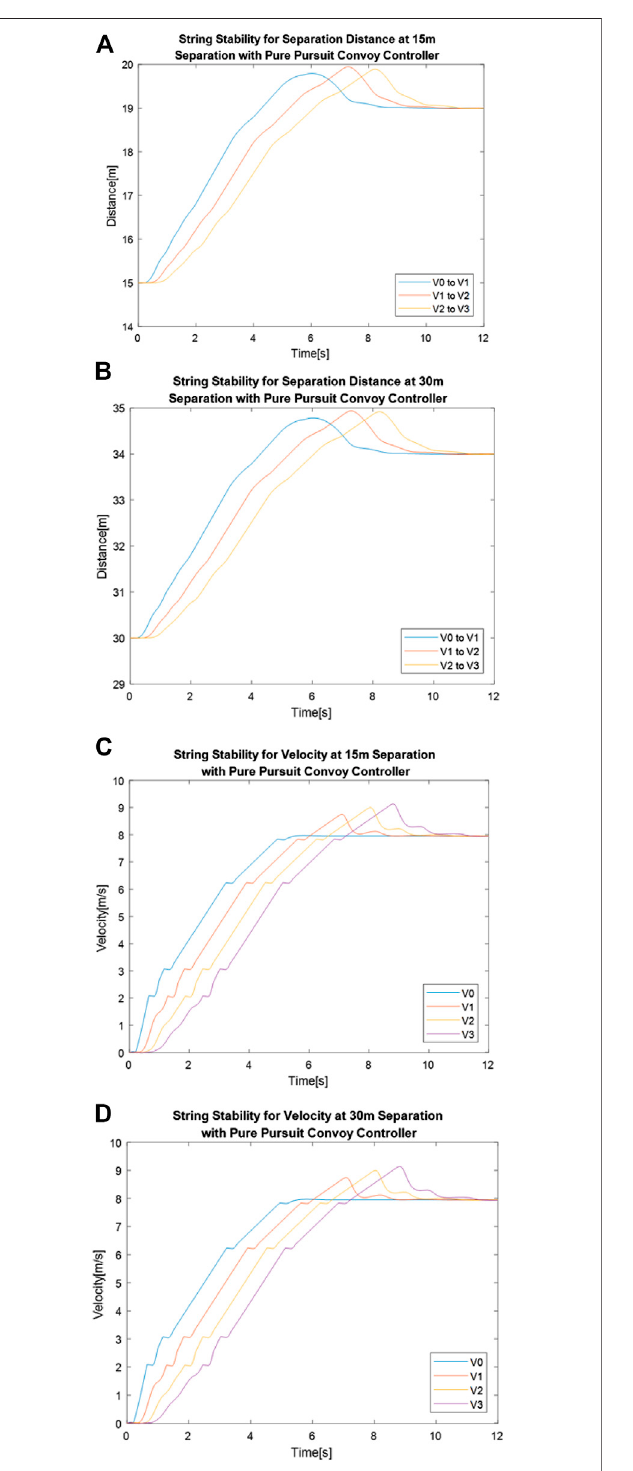
FIGURE 8 | Pure Pursuit convoy controller performance for separation distance between vehicles with a gap distance of (A) 15 m and (B) 30 m and velocity of vehicles over time with a gap distance of (C) 15 m and (D) 30 m.